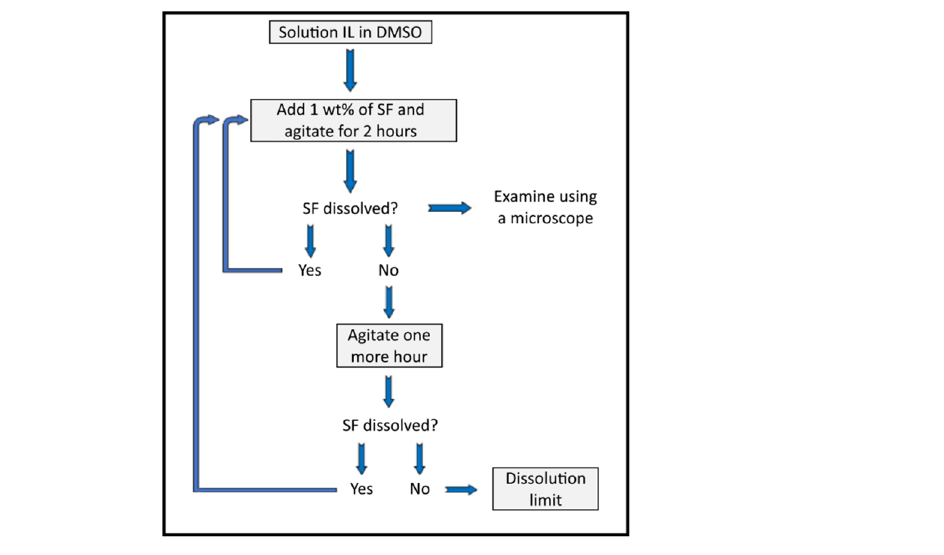
Figure 3. Flow chart for the steps of silk fibroin dissolution in ionic liquid/DMSO binary mixtures, adapted with permission from Dignani et al. [14], adapted with permission, MDPI, 2020.